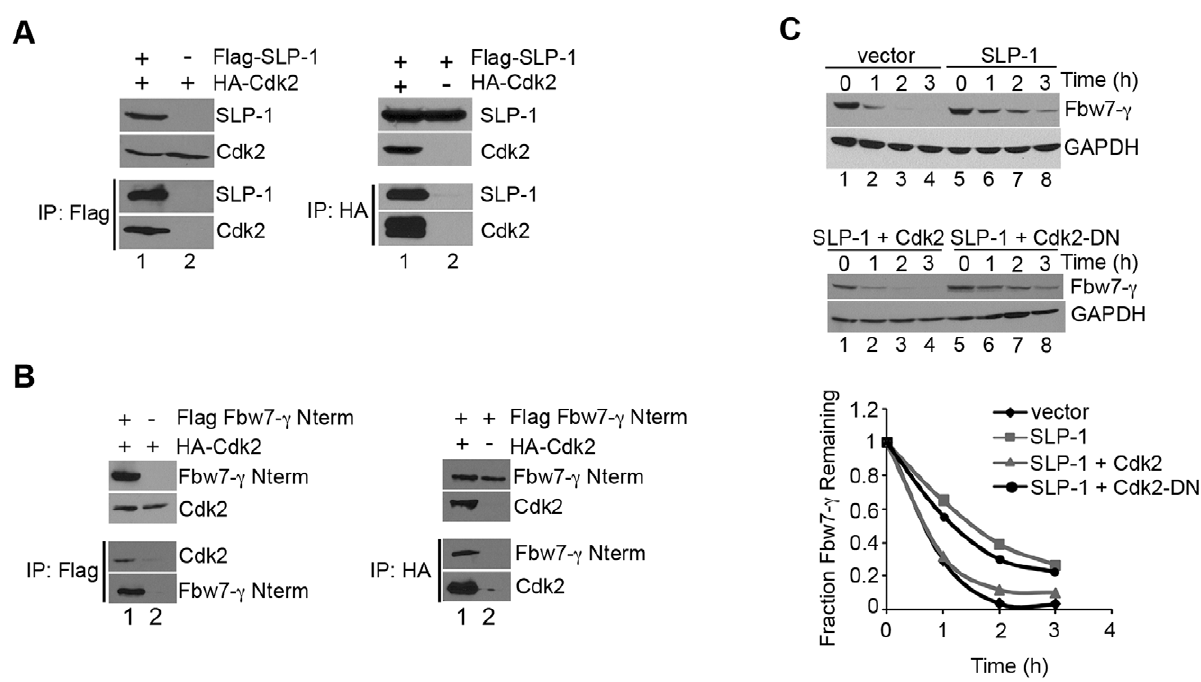
Figure 4. SLP-1 and Fbw7- c interact with Cdk2. A) SLP-1 interacts with Cdk2. HA-tagged Cdk2 was transfected with Flag-tagged SLP-1 or empty vector into HEK293T cells. Co-immunoprecipitations were performed as described in Materials and Methods. B) Cdk2 interacts with Fbw7- c . Co-IPs were performed as in (A) in cells expressing the indicated proteins. C) Co-expression of Cdk2 and SLP-1 promotes turnover of Flag-tagged Fbw7- c . Protein stability assays were performed as described in Materials and Methods in cells expressing the indicated proteins. Quantitation of a representative experiment is shown in the graph.